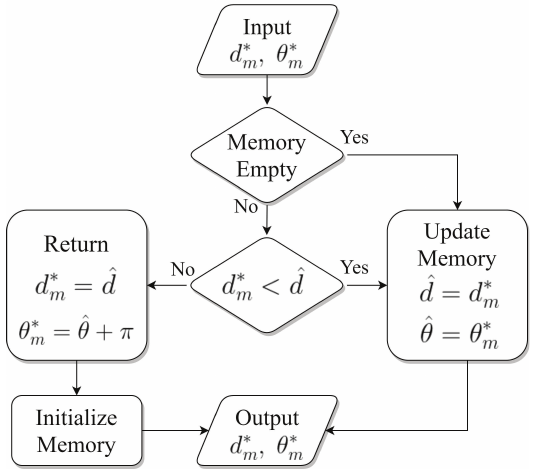
Figure 4. Memory